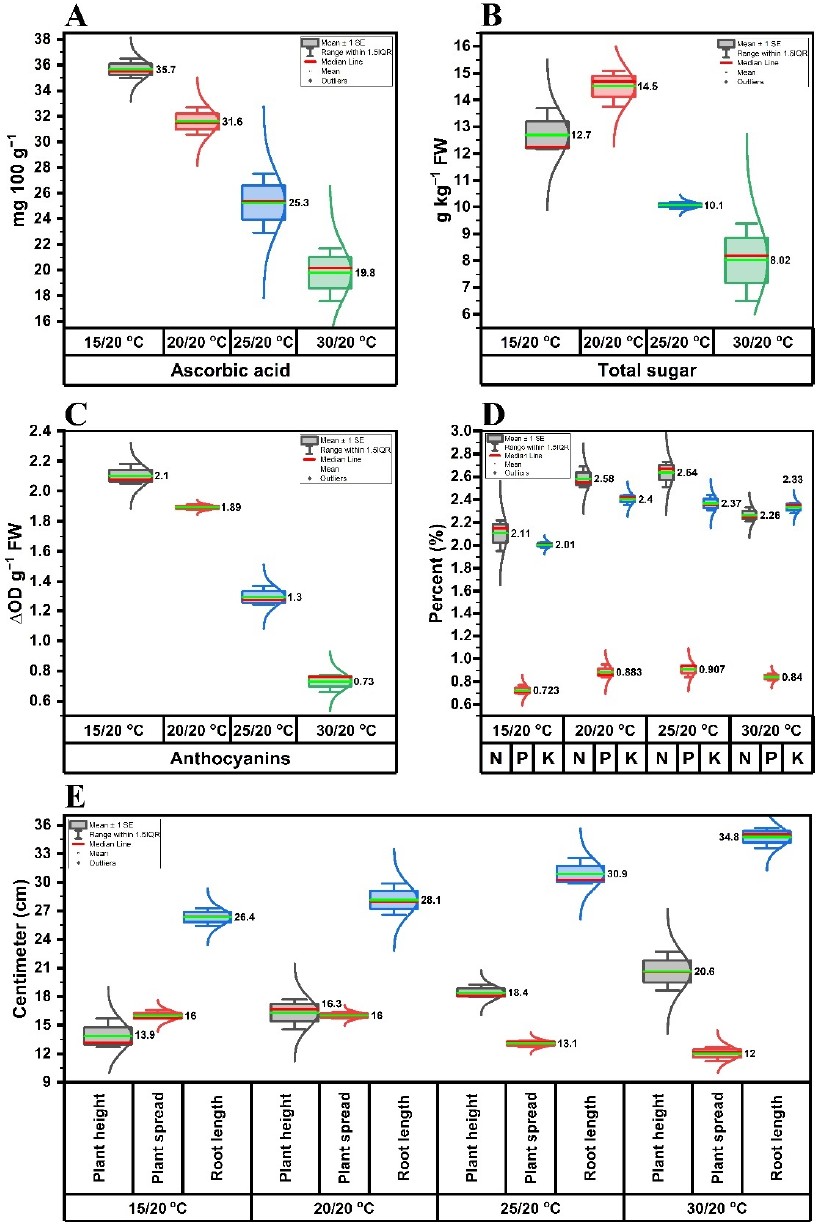
Figure 3. Effects of different day/night temperatures on the biochemical and growth attributes of butterhead lettuce cv. Gustav, including ( A ) ascorbic acid content, ( B ) total sugar content (TS), ( C ) anthocyanin content, ( D ) nitrogen, phosphorous, and potassium contents, and ( E ) plant height, plant spread, and root length. The horizontal red bar represents the median, and the green bars represent the mean value. The side lines along each box represent the data curve. Each data point is the mean of three independent biological replicates. The statistical analysis is based on a single-factor completely randomized design. The comparison of treatment means was performed by the least significance difference (LSD) test ( p ≤ 0.05) for day/night